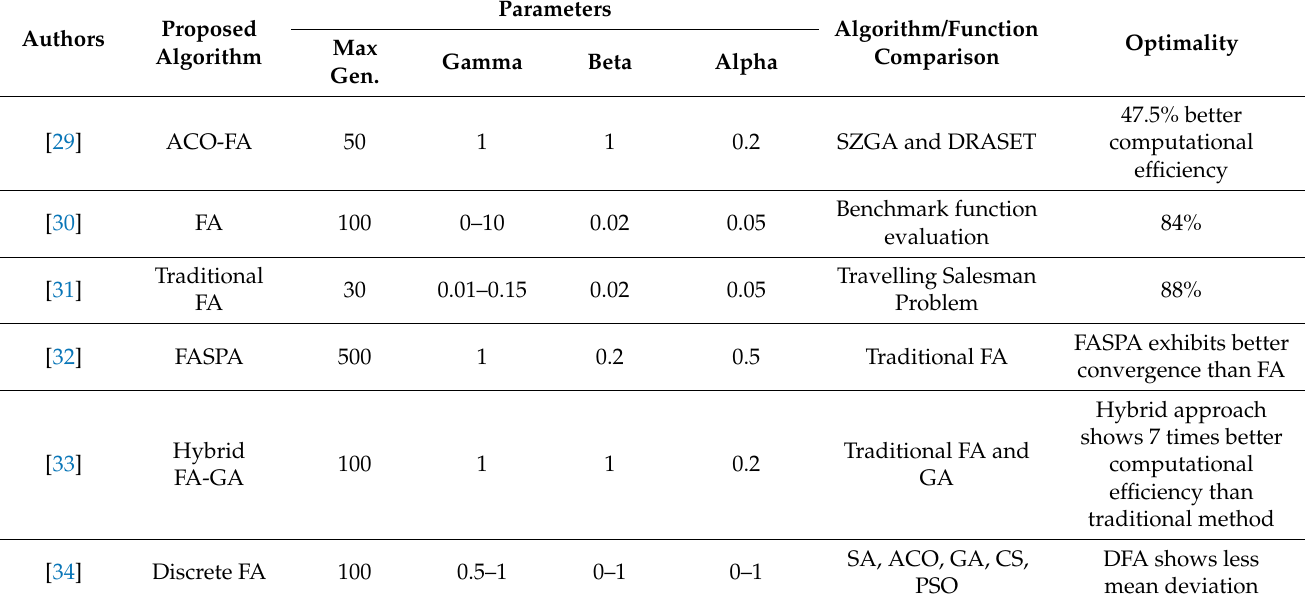
Table 2. Parameter-setting of some selected literature for